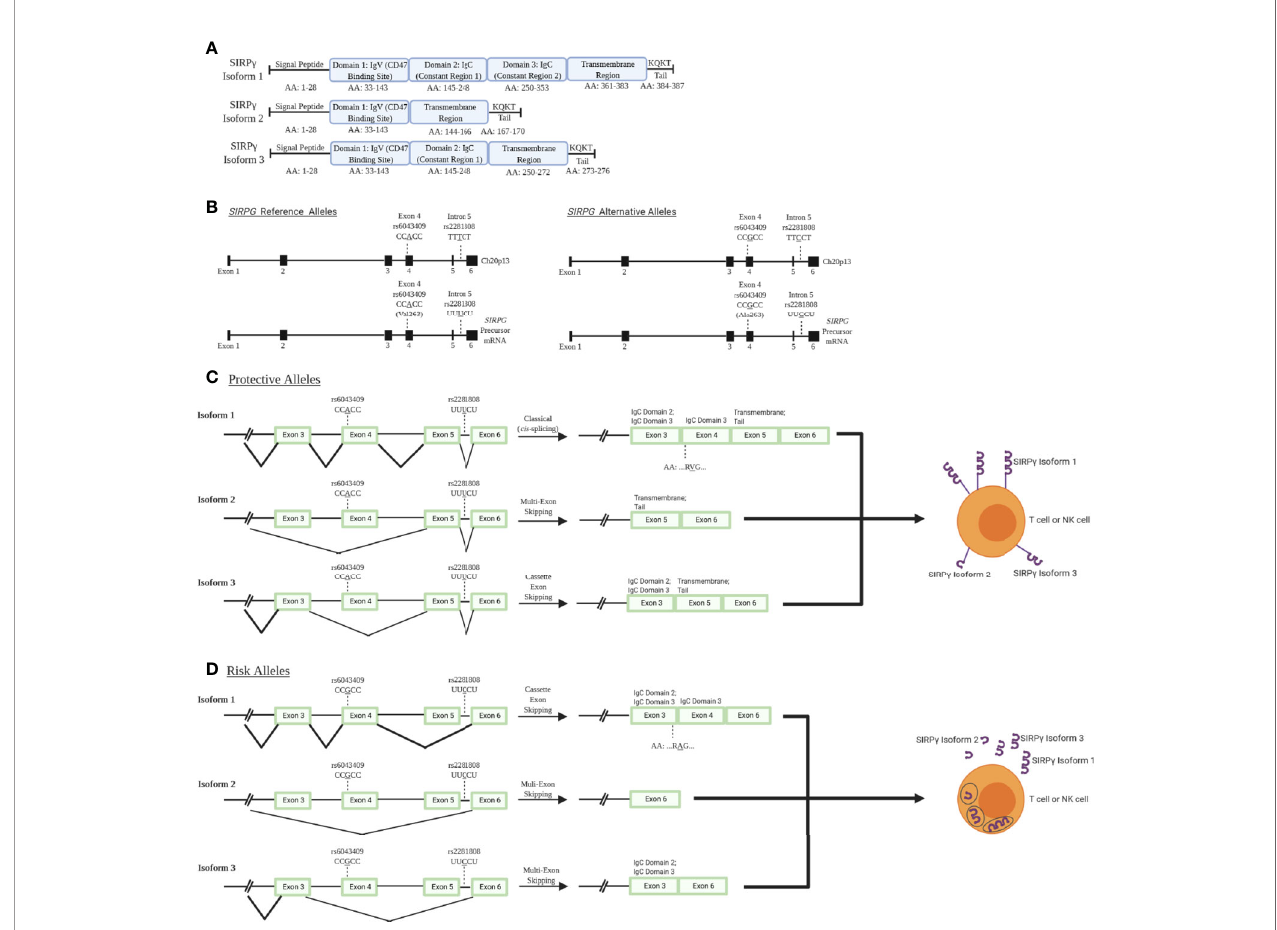
FIGURE 1 | SIRP g isoforms and predicted consequences of rs2281808 and rs6043409 SNPs: T1D-associated SNPs in signal regulatory protein gamma ( SIRPG ) may alter splicing activity and thereby surface SIRPG expression. (A) Isoform 1 (NCBI Reference Sequence: NP_061026.2) is the longest and most predominant form of the protein, while isoform 2 (NP_543006.2) and isoform 3 (NP_001034597.1) are shorter and less frequently observed (18, 19). All isoforms contain domain 1 (D1), which is the immunoglobulin variable (IgV) region that binds to CD47. However, only isoform 1 contains two immunoglobulin constant (IgC) regions and a known transmembrane region at the end of the protein structure. Isoform 3 contains at least one IgC, while isoform 2 has no constant region. (B) Gene and pre-mRNA diagrams of SIRPG (NCBI reference sequence for gene: NC_000020.11, Gene ID: 55423; precursor mRNA for isoform 1: NM_018556.41). Reference and alternative alleles for rs2281808 and rs6043409 are shown. (C) We speculate that the protective alleles of rs2281808 and rs6043409 are associated with “ normal ” SIRPG splicing and high membrane SIRP g expression on T cells and NK cells, while (D) SIRPG risk alleles might promote aberrant splicing, potentially resulting in a loss of exon 5, which encodes most of the transmembrane region. We expect this would cause lower membrane expression of SIRP g as well as increased SIRP g